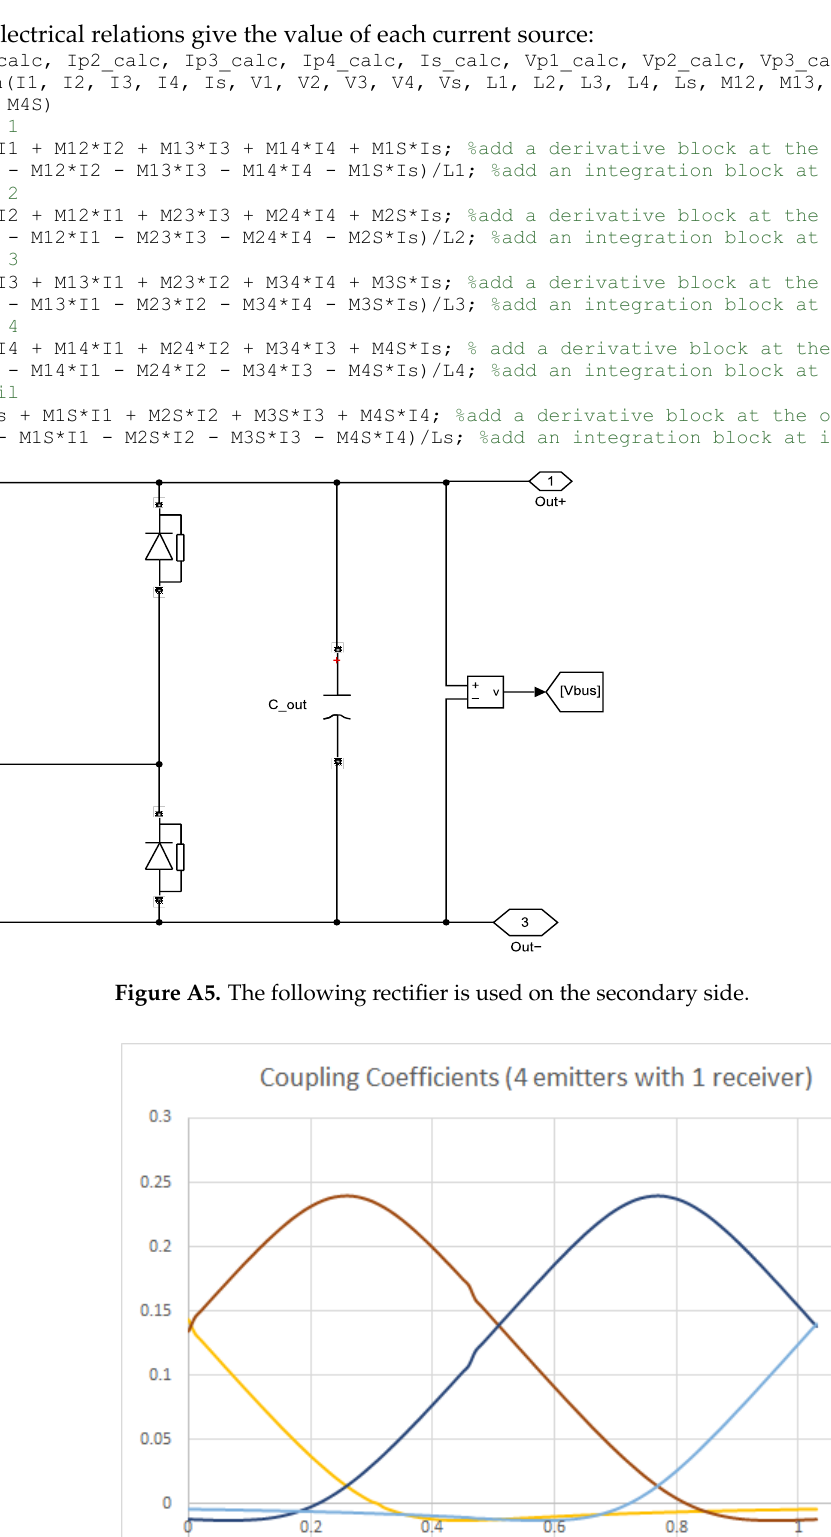
Figure A4. Model of the magnetic couplers.